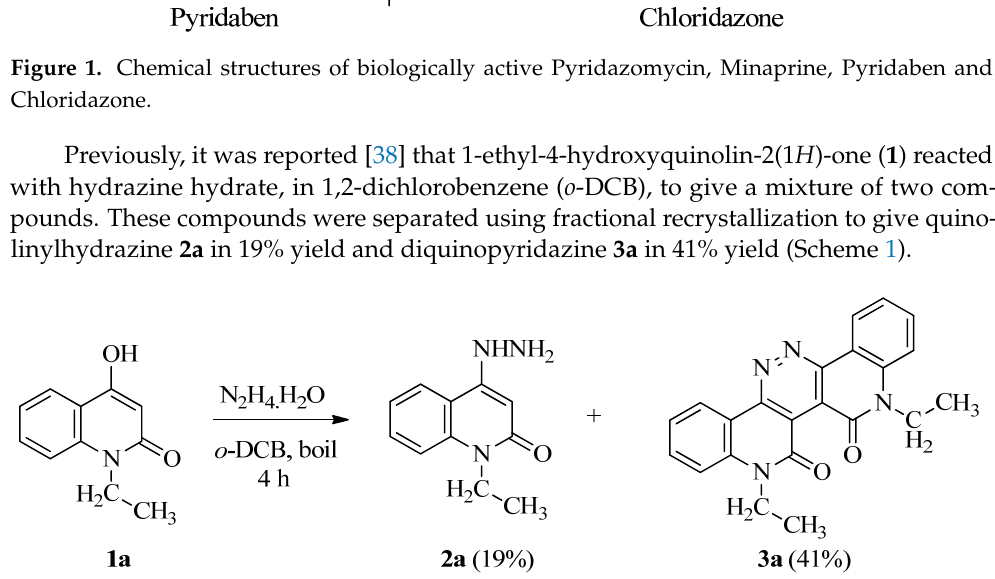
Figure 1. Chemical structures of biologically active Pyridazomycin, Minaprine, Pyridaben and Chloridazone.